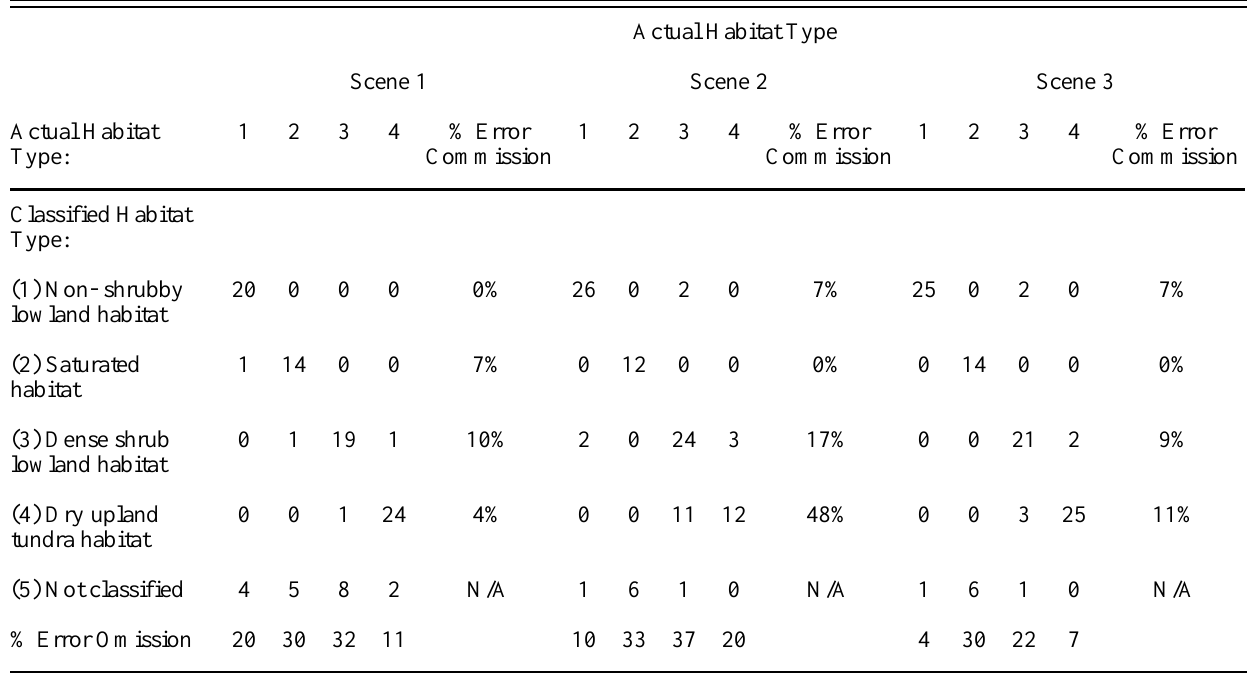
Table 4. Error matrix resulting from accuracy assessment of the supervised classification for the three scenes representing the Kendall Island Bird Sanctuary and Fish Island in the outer Mackenzie Delta, Northwest Territories. Values represent the number of pixels classified as a particular habitat type in relation to their actual habitat type, out of 100 in each scene. Incorrect values reading down represent errors of omission (pixels incorrectly excluded from a habitat class), whereas incorrect values reading across represent errors of commission (pixels incorrectly included in a habitat class). A total of 100 pixels were sampled from each scene, with an estimated overall accuracy of 77%, 74%, and 85% in scenes 1, 2, and 3,